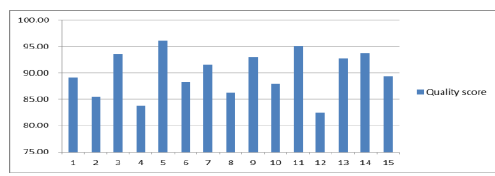
Figure 1 . The 15 project quality score statistics table